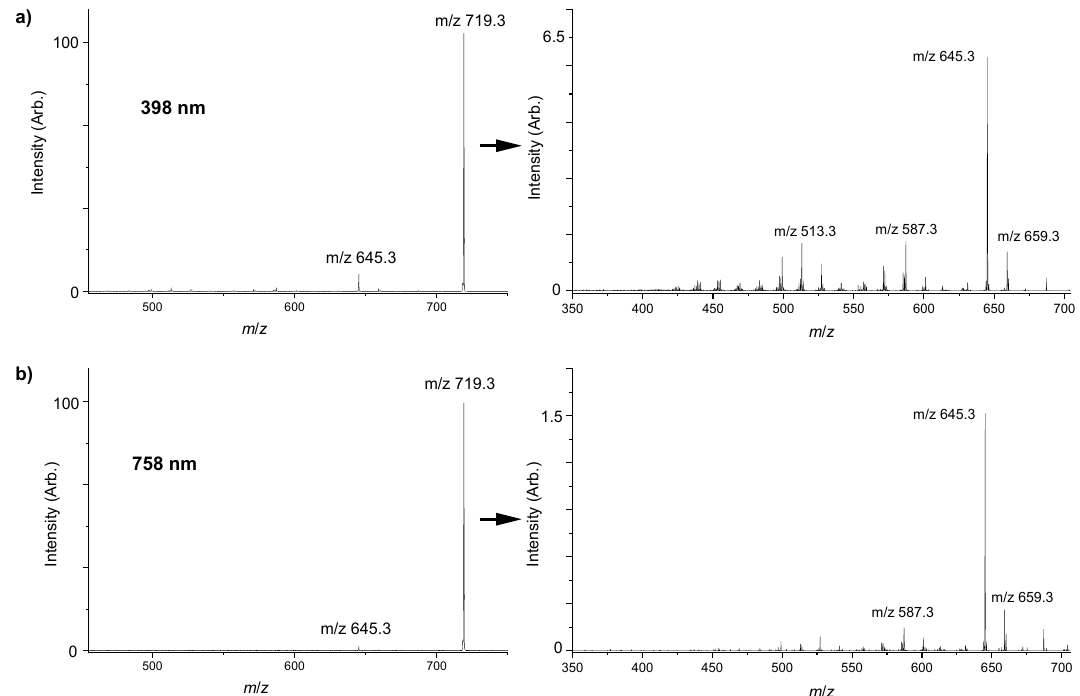
Figure 3. ( a ) Photofragment mass spectrum of protonated verteporfin, excited at photodepletion maxima at 398 nm. Laser pulse 0.05 mJ. ( b ) Photofragment mass spectrum of protonated verteporfin, excited at 758 nm. Laser pulse 0.20 mJ. The spectra on the right are an expansion of the respective spectrum on the left to allow the visualization of the minor fragment peaks.